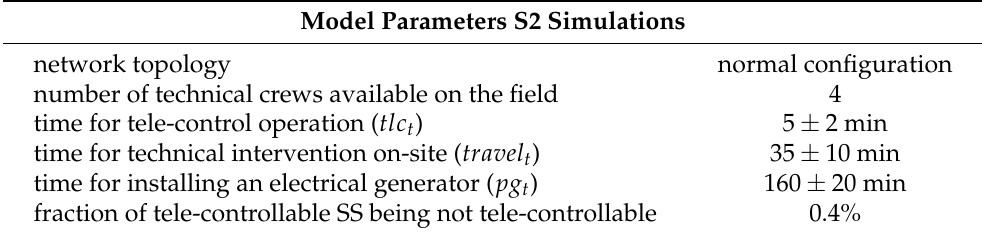
Table 3. Parameters used for S2 ( low traffic )